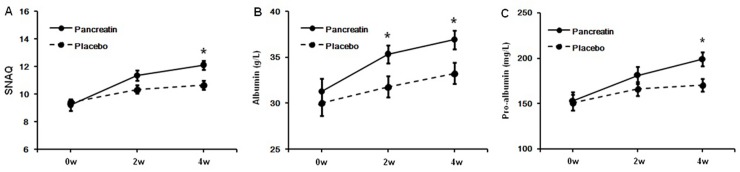
The effect of pancreatin on the appetite loss was evaluated in CHF patients with FE-1 levels <200 μg/g stool and SNAQ < 14.A. SNAQ score; B. Albumin; C. Pro-albumin. Compared with placebo group, pancreatin could significantly improve the SNAQ score in treatment group as well as albumin and pro-albumin. The data are expressed as means ± SD. *p<0.05.